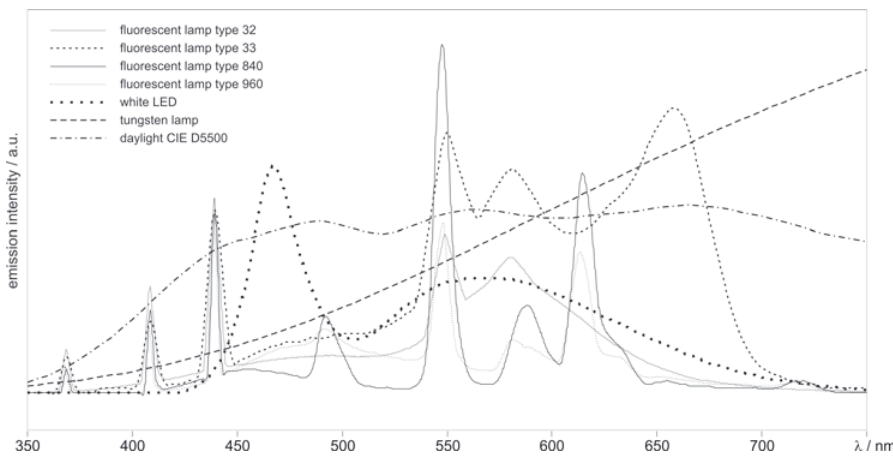
Figure 1. Spectral distribution of the seven types of white light sources used in this